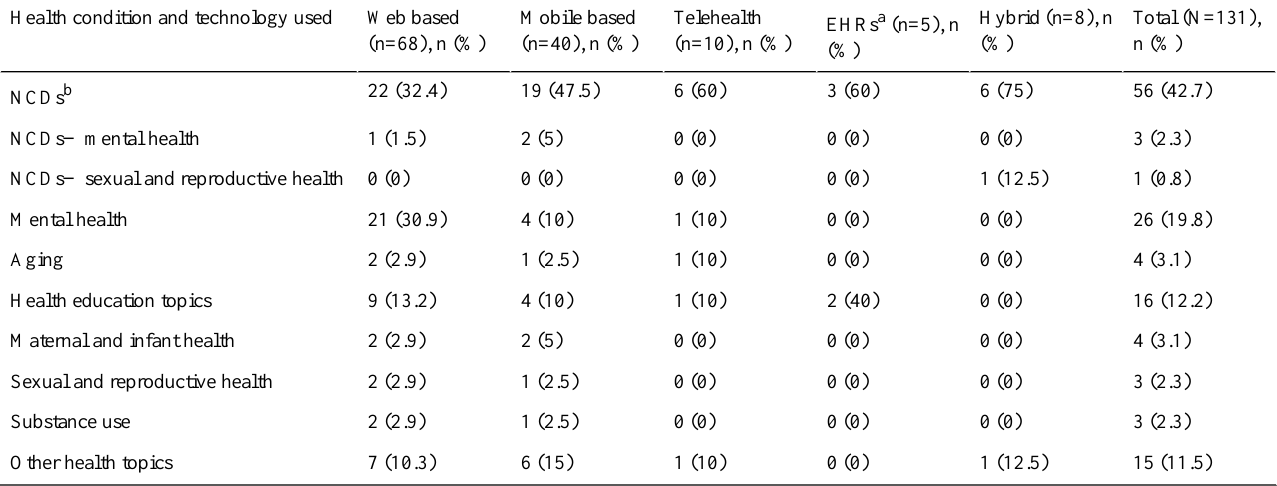
Table 2. Number of studies by health condition category and type of technology used.